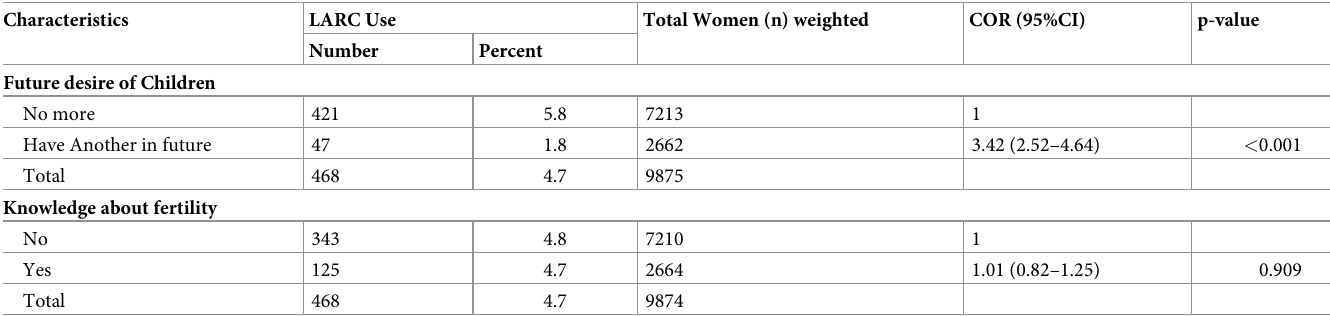
Table 2. Fertility related characteristics and use of